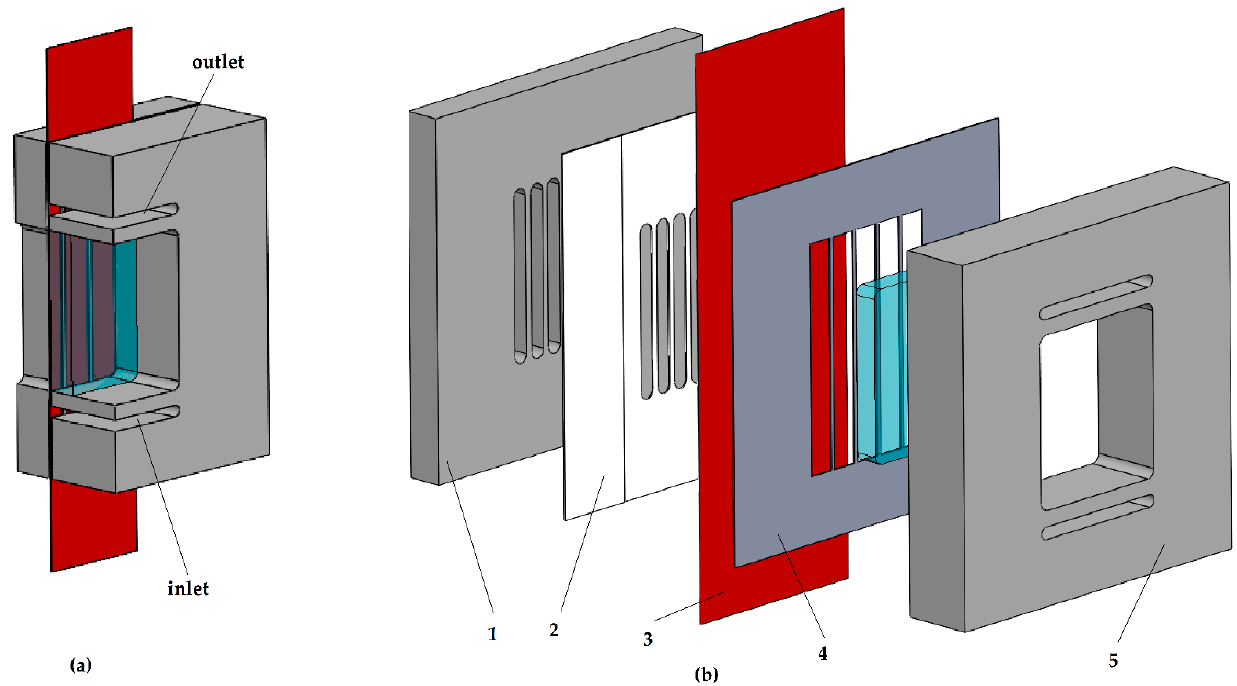
Figure 1. The test section: ( a ) assembly drawing; ( b ) main elements: 1–top cover, 2,4–Teflon spacer, 3–heated foil, 5–glass panel, 6–channel body.